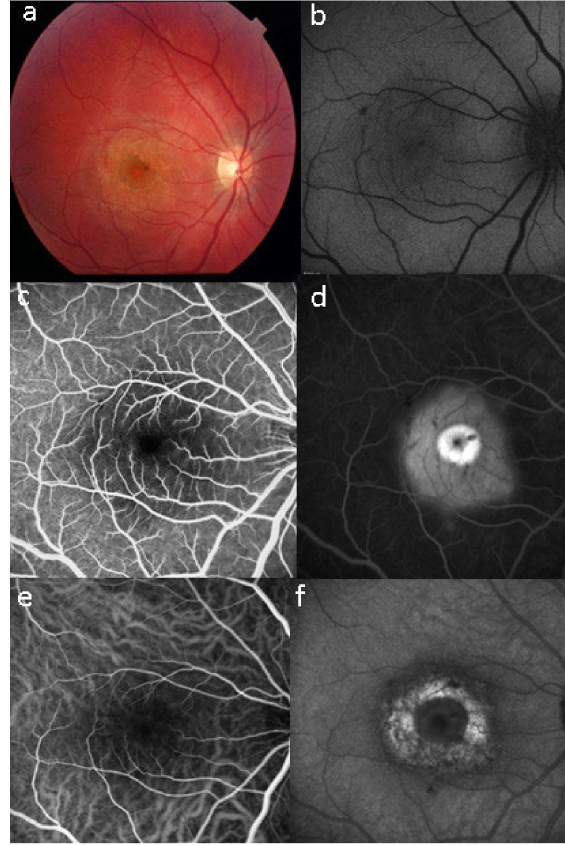
Figure 35. Images of a case of UIAM a week after the onset of symptoms. ( a ) fundus photography showing well-circumscribed area of RPE atrophy and hyperplasia. ( b , c ) BAF and NIR-FAF show stippled hyperautofluorescence, more evident in NIR mode, indicating increase not only of lipofuscin but especially of melanin and compounds closely related to melanin. ( d ) FA in the late phase shows hyperfluorescence (staining). ( e , f ) ICGA early and late phases reveal only in the late phase of the angiography a large area of hypofluorescent dark area, sign of choriocapillaris ischaemic